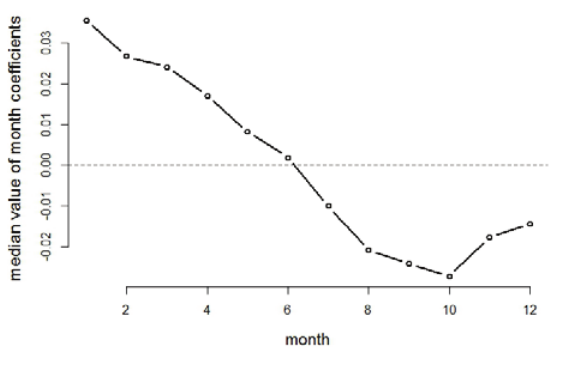
Figure 10. Month coefficients estimated from the